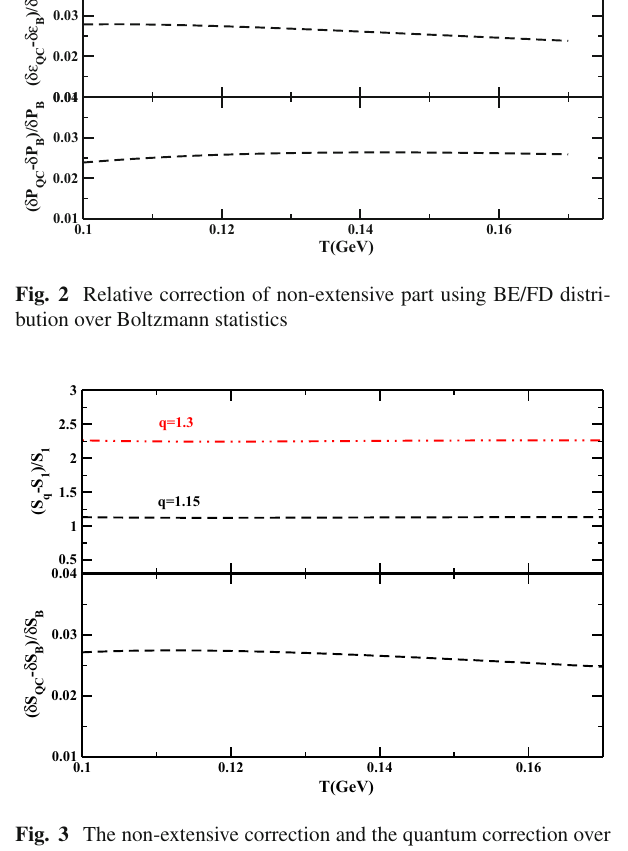
for q = 1, q = 1 . 15 and q = 1 . 3 in Fig. 4. For a sys- tem composed of massless particles the value of c 2 becomes 1 / 3 (which is the Stefan–Boltzmann (SB) limit) irrespective of the value of q , which is depicted by the dot- ted straight line. For a massive pion–nucleon gas, c 2 the usual increasing trend with increasing temperature for all values of q , which tends to approach the SB limit at consid- erably high temperatures. With higher q values the speed of sound appears to become larger which is in accordance with Ref. [56] and faster approaches the SB limit. This increment is much expected due to the significant increase in the system pressure in a non-extensive environment with respect to the ideal ( q = 1) one. The kink in the temperature dependence (the minimum most point) below 0 . 2 GeV agrees with of c 2 s the lattice results, where with increasing q values the shift of the kink towards lower temperatures (0 . 145–0 . 150 GeV) indicates the fact that the minimum of the speed of sound lies on the low temperature side of the crossover region